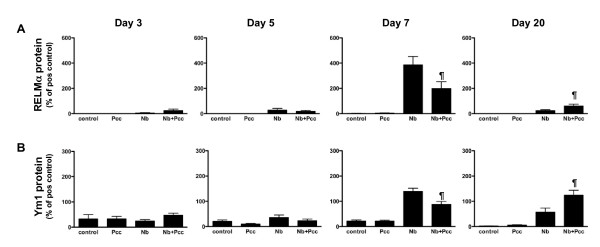
Western blot analysis of ChaFF protein expression in BALF of Nb, Pcc and co-infected mice. Lung lavages harvested at days 3, 5, 7 and 20 pi indicated that the ChaFF proteins RELMα (A) and Ym1 (B) exhibited temporal dynamics that were similar to those observed for mRNA expression in lung tissue (Fig. 4). In particular, expression of both proteins was significantly lower in the lungs of co-infected (Nb+Pcc) than in Nb mice at 7 days pi (RELMα P = 0.0067 and Ym1 P = 0.0104). This pattern had reversed by 20 days pi, with increased ChaFF protein expression in Nb+Pcc compared to Nb mice (RELMα P = 0.0398 and Ym1 P = 0.0171). Data are expressed as percentage of a positive control sample (pooled lung lavages of three Nb-infected mice). Bars indicate mean ± SEM of combined results of 2 independent experiments, each with 4-9 mice per group per timepoint. The symbol ¶ indicates significance of the difference between co-infected and Nb mice (P values included above and in Results text).